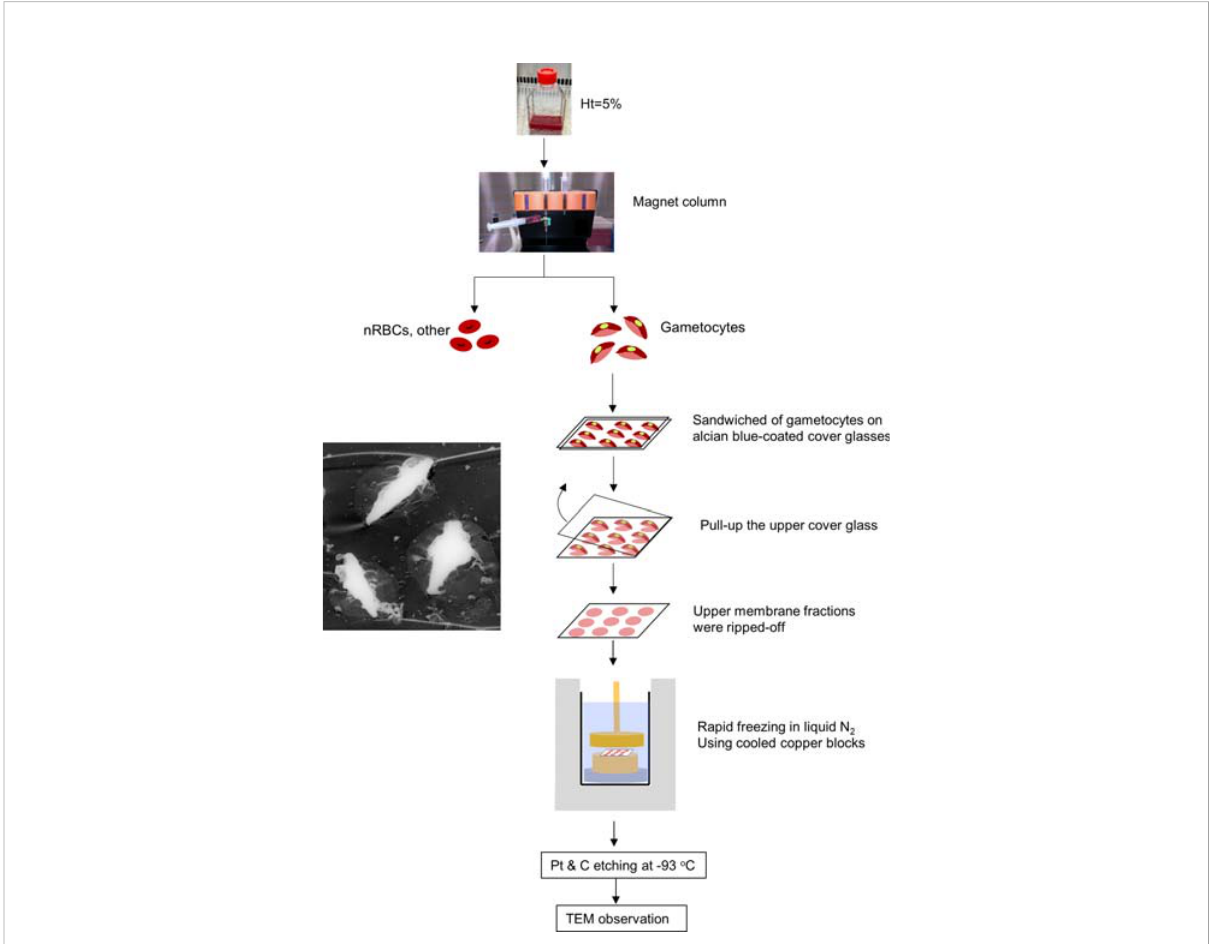
FIGURE 4 Gametocyte-erythrocyte unroo fi ng sample preparation for TEM observation Flow of unroo fi ng preparation for gametocytes. Gametocytes, after NAG-treatment to remove asexual parasites, were puri fi ed slowly using MACS Separators, transferred onto Alcian-blue – treated micro cover glass, and covered with another micro cover glass. The upper membranes of the erythrocytes and gametocytes were removed by pulling up the top micro cover glass. This step removed the upper membrane layers of erythrocytes with gametocytes and exposed the inner structures (TEM image, left panel). After preparing freeze-etching replica with LN 2 and cooled copper blocks, all replicas were coated with platinum (Pt) and carbon (C) for TEM